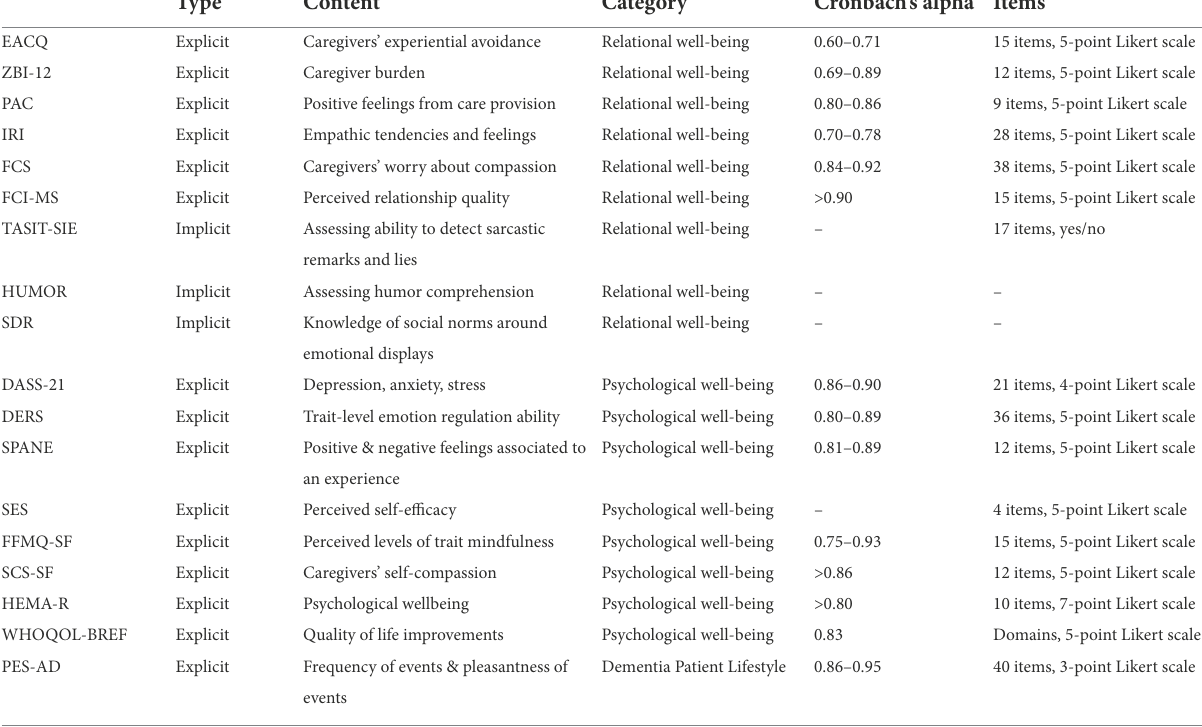
TABLE 3 Measurement description by